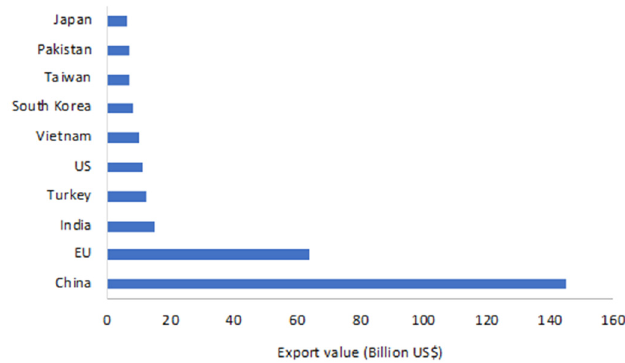
Figure 1. Top 10 exporters of textiles in 2020 (Data source: [3]).